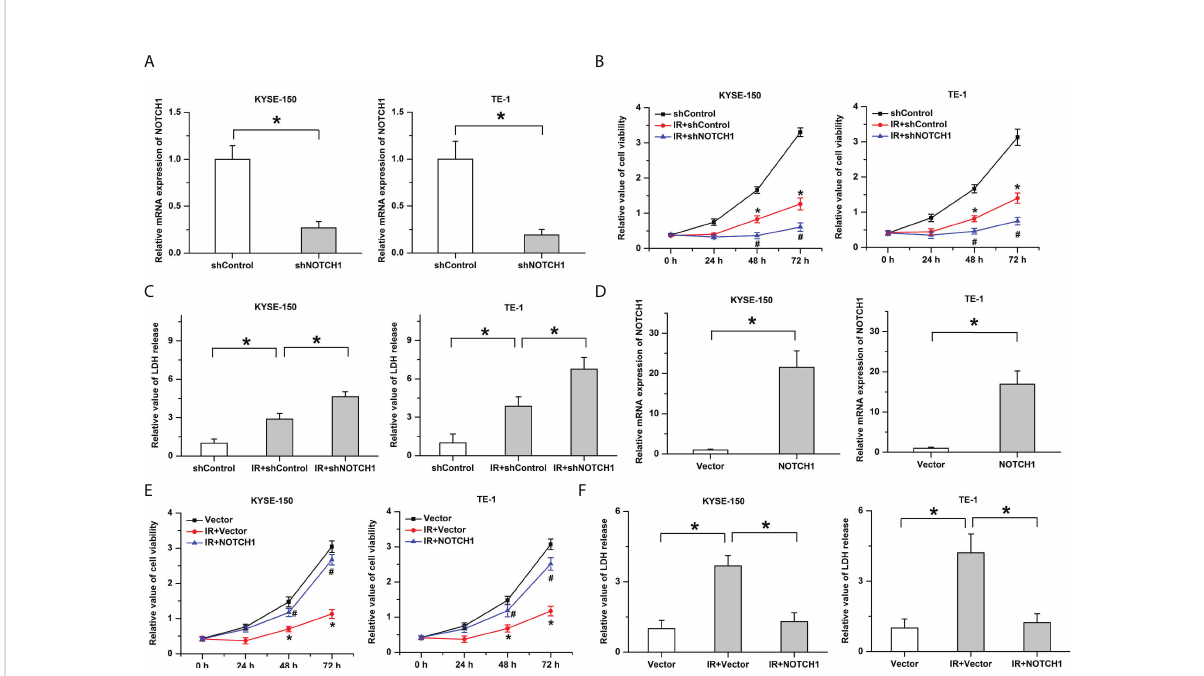
FIGURE 5 The response to radiotherapy is negatively regulated by NOTCH1. (A) The knockdown ef fi ciency was veri fi ed by real-time PCR in ESCC cells. (B) Ionizing radiation (IR)-induced the decrease of cell viability was facilitated by the knockdown of NOTCH1. * indicates p < 0.05 compared with shControl group, # indicates p < 0.05 compared with IR+shControl group. (C) The promotive effects of IR on LDH release were enhanced by NOTCH1 knockdown. (D) Real-time PCR was utilized to determine the overexpression ef fi ciency. (E) The decrease of cell viability induced by IR was attenuated by the overexpression of NOTCH1. * indicates p < 0.05 compared with Vector group, # indicates p < 0.05 compared with IR+Vector group. (F) IR-induced cell death was mitigated by NOTCH1 overexpression in ESCC cells. All data was represented as the mean ± standard error of the mean (SEM) from at least three independent experiments. Vector and shControl were utilized as the internal reference to calculated the relative values,